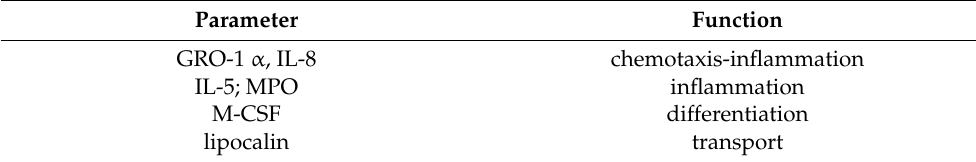
Figure 4. Representative protein profiler arrays for whole blood incubated with either medium (negative control) or PLGA. Proteins with a significantly increased concentration compared to control were marked. (a): GRO α (D1 – 2), (b): IL-5 (E3 – 4), (c): IL-8 (E7 – 8), (d): M-CSF, (e): MPO (H1 – 2). Table 2. Expressed parameters with significant differences between groups and assignment to functional